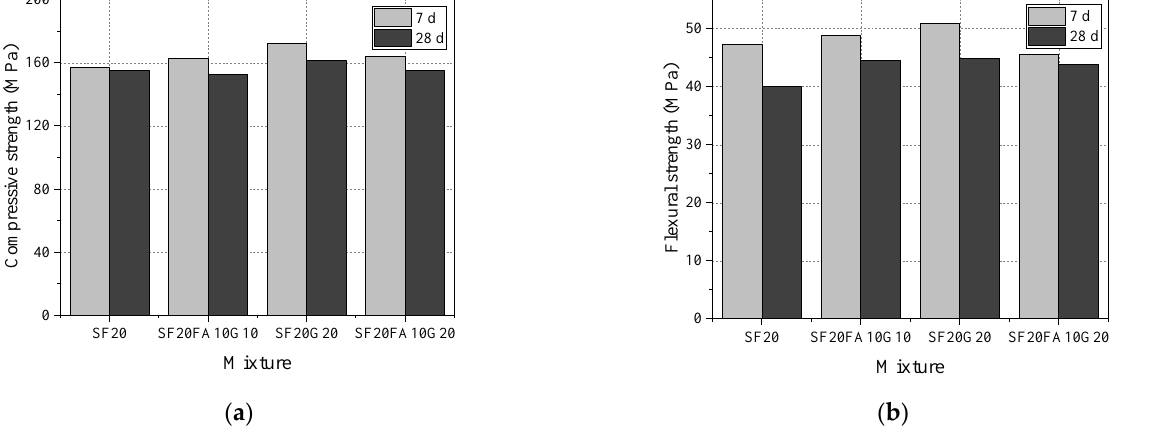
Figure 2. Compressive and flexural strengths of EUHPC under steam curing: ( a ) compressive strength; ( b ) flexural strength.